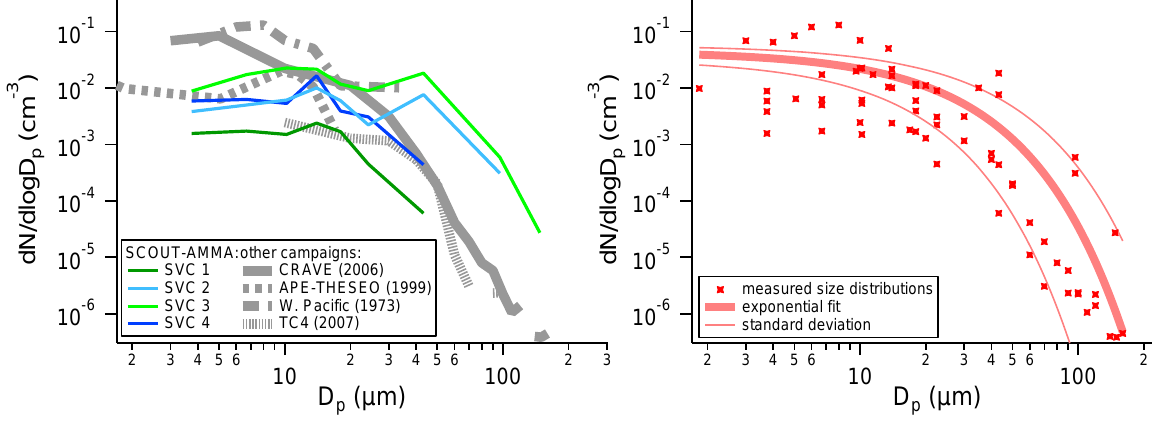
Fig. 17. Left panel (adapted from Davis et al., 2010): overview of in situ measurements for tropical SVC. The observations obtained during the indicated previous field experiments are shown in broad grey lines. The coloured lines depict the individual cloud encounters from SCOUT-AMMA in West Africa. Right panel: an exponential fit was derived from all size distributions in the left panel with one sigma deviations. See Eq. (3) for the fit equation and